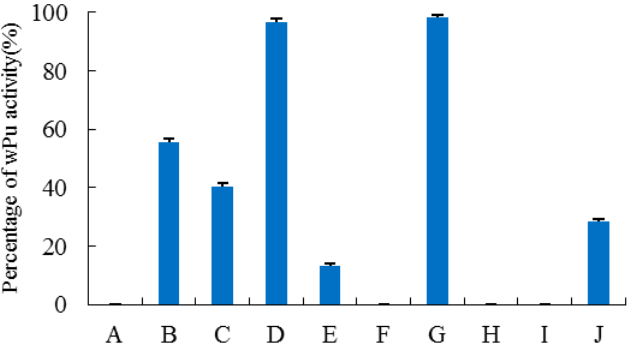
Figure 1. Enzymatic activity of porcine–human chimeras generated during exon replacement and exon restoration study. The enzymatic activity is expressed as a percentage of the activity observed for wPU. ( n = 5, error bars represent standard deviation). (A) dHU; (B) H 1-2 P 3-8 ; (C) P 1-2 H 3 P 4-8 ; (D) P 1-3 H 4 P 5-8 ;